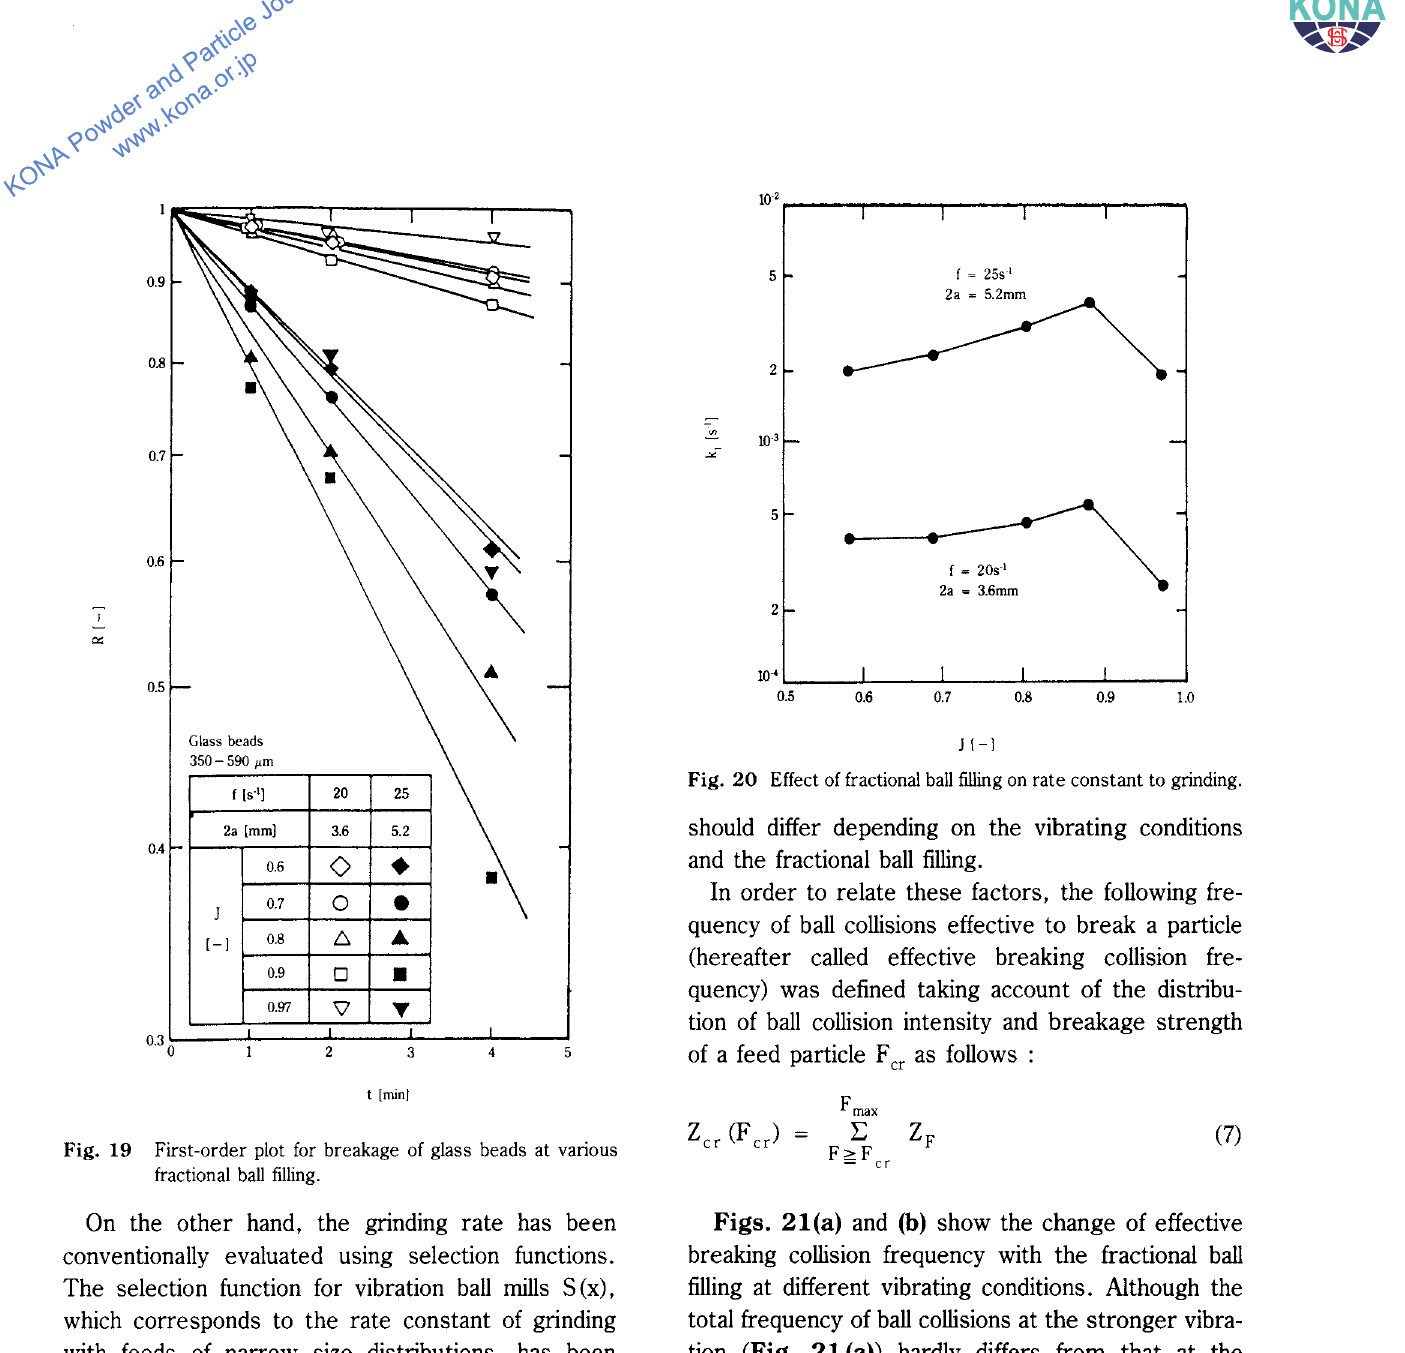
Fig. 19 First -order plot for breakage of glass beads at various fractional ball filling.